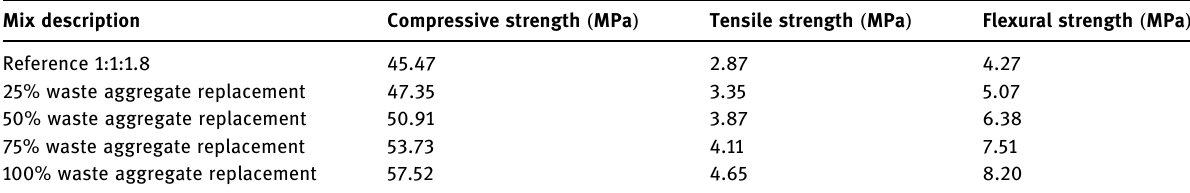
Table 7: Mechanical properties of reference and waste tiles aggregate concrete modi fi ed with PC superplasticizer Mix description